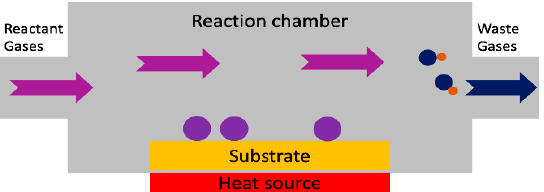
Figure 10. Schematic of a chemical vapor deposition (CVD) system with the basic components and operation.